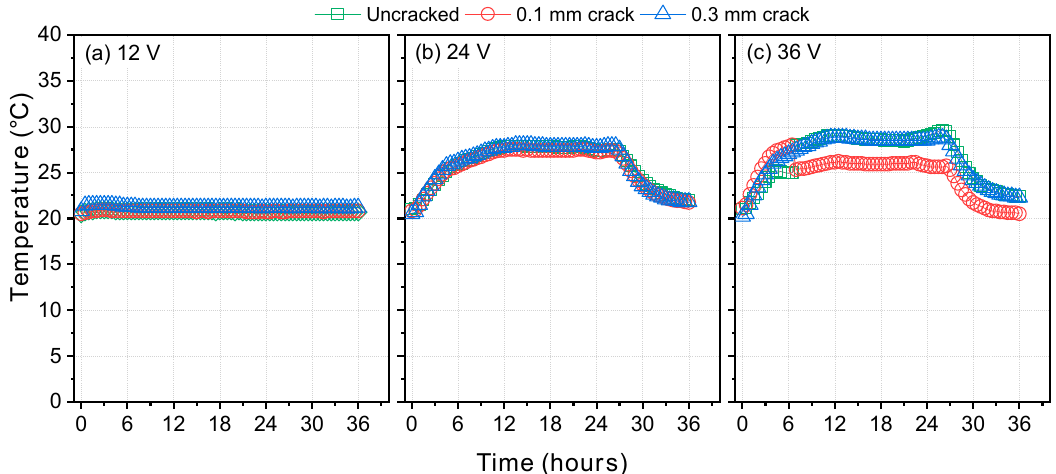
Figure 7. Temperature rise in the chloride solution in the upstream cell during the test: ( a ) 12 V; ( b ) 24 V; ( c ) 36 V.